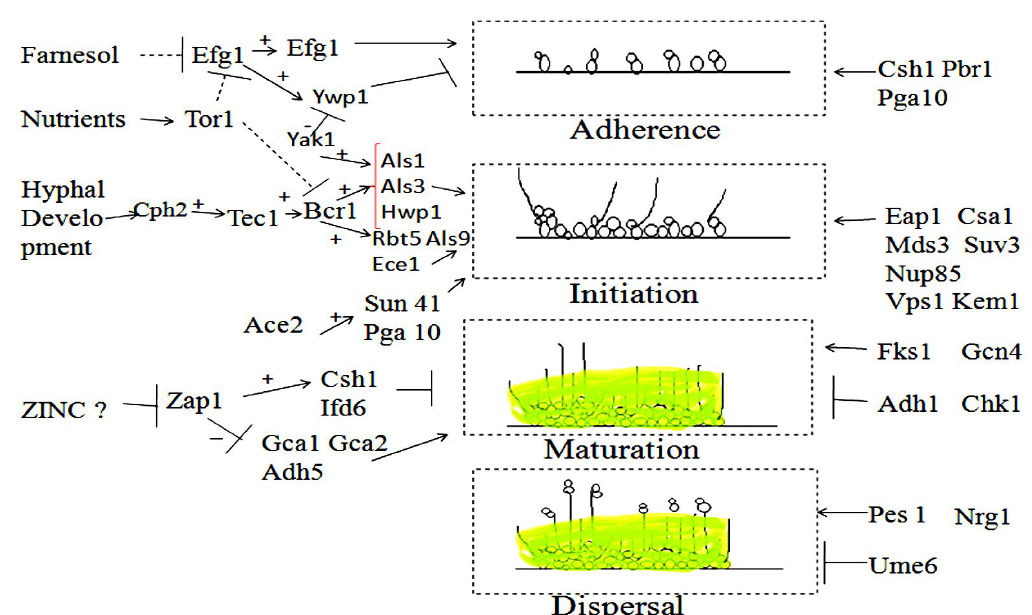
Fig. 2. Different genes are presented here which showed function in Biofilm formation. It has four steps (I) Adherence, (II) initiation, (III) maturation, and (IV) dispersal. In the right-hand side part of the diagram, the genes are connected and involve in pathway but in the left hand side part, the genes may not attach to an established pathway but function in a particular step. Arrows signify positive connection, the Dashed line signify repression by an indirect mechanism. "+" sign indicates that an upstream gene stimulates the expression of the downstream target and "-" sign is opposite of it. "T-shaped" indicated a negative relationship (repression by an indirect